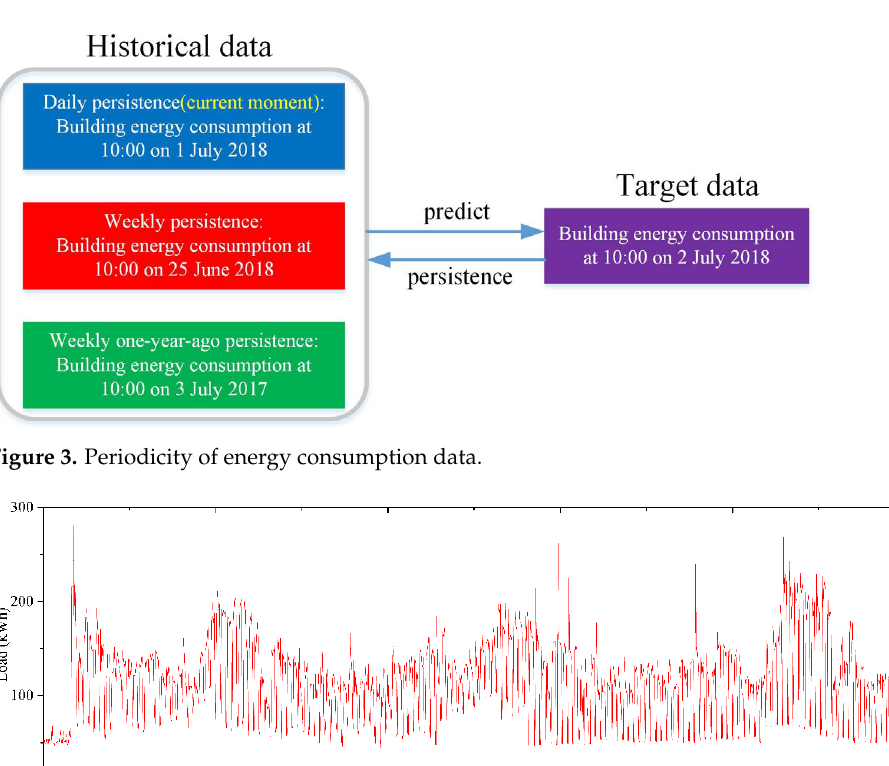
Figure 3. Periodicity of energy consumption data.